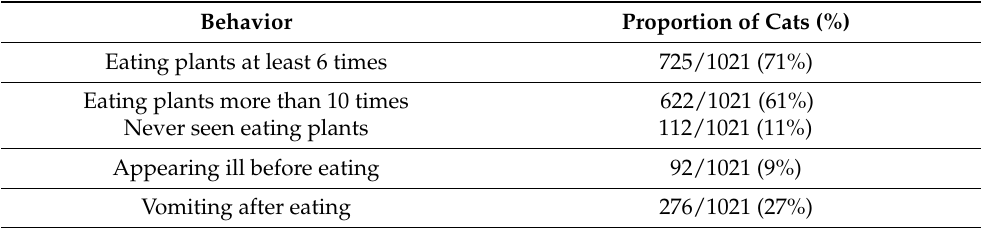
Table 2. Cats’ frequency of eating plants and behaviors prior to and following eating plants, from Survey 2. In several instances, the behaviors before or after eating plants were not clear to the owner, so these responses were not included in the percentages. Behavior Proportion of Cats (%) Eating plants at least 6 times 725/1021 (71%) Eating plants more than 10 times 622/1021 (61%) Never seen eating plants 112/1021 (11%) Appearing ill before eating 92/1021 (9%) Vomiting after eating 276/1021